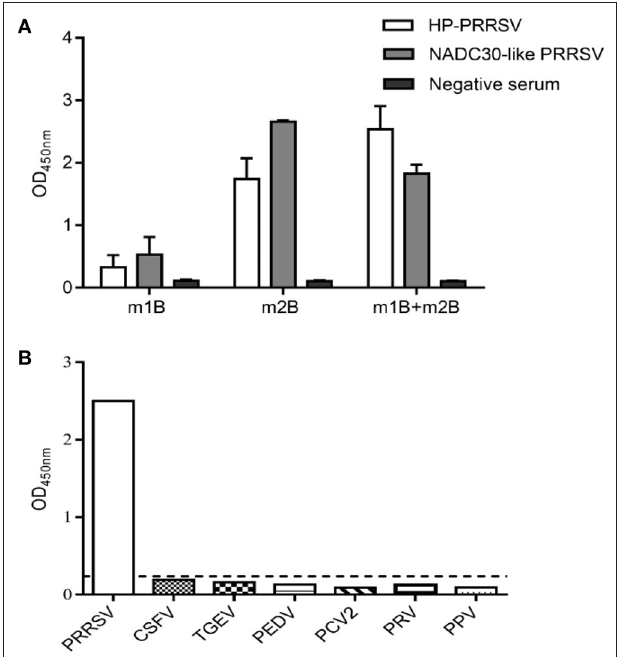
FIGURE 3 | Antigenicity analysis and cross-reactivity assessment of m1B and m2B. (A) Indirect ELISA of m1B or m2B peptides. ELISA plates were coated with synthesized peptides, whereas pig serum positive for HP-PRRSV or NADC30-like PRRSV was used as the primary antibody. (B) ELISA plates were coated with synthesized peptides, whereas positive serum for PRRSV, CSFV, PEDV, PRV, PPV, and PCV2 was used as the primary antibody. The black dotted line represents the cutoff value of 1B2B-ELISA. HP-PRRSV, highly pathogenic PRRSV; CSFV, classical swine fever virus; PEDV, porcine epidemic diarrhea virus; PRV, pseudorabies virus; PPV, porcine parvovirus; and PCV2, porcine circovirus type 2.